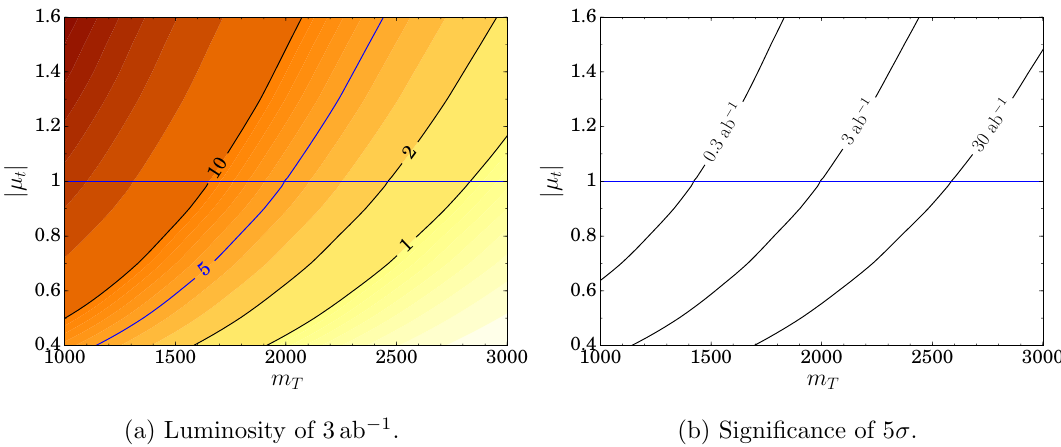
Figure 3. Discovery reach de(cid:12)ned as Z ( b